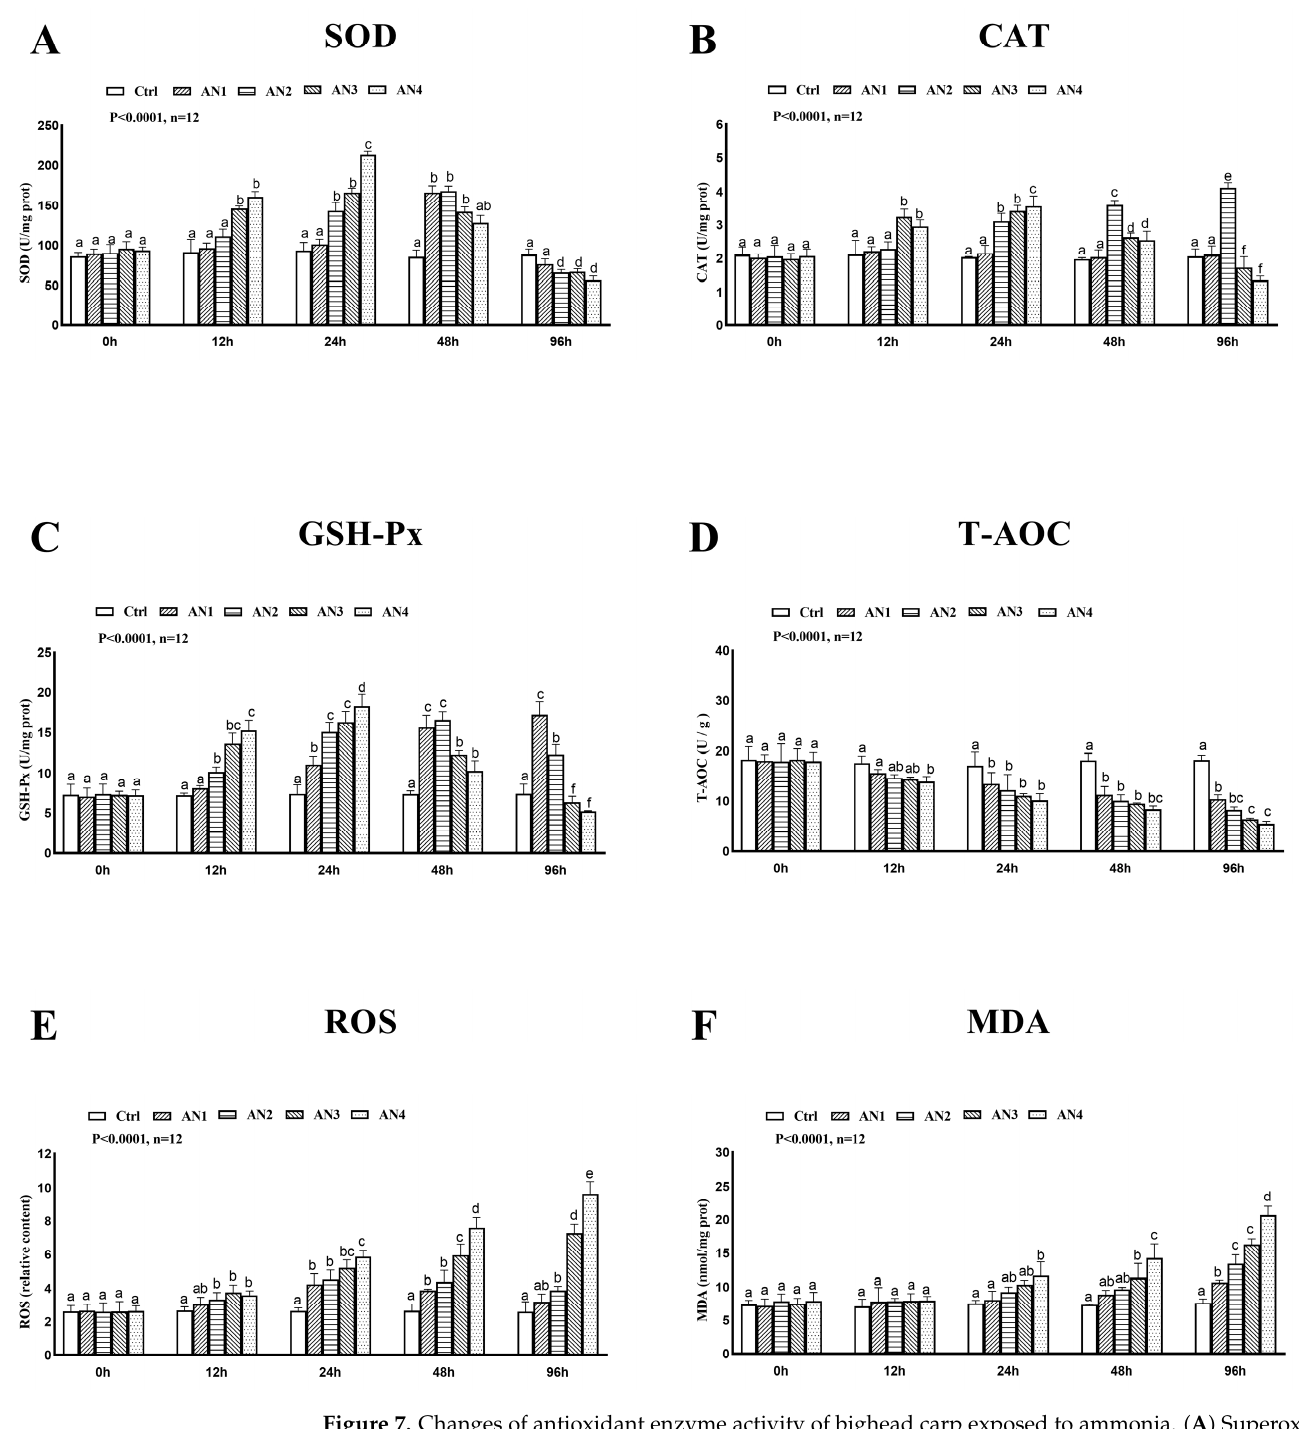
Figure 7. Changes of antioxidant enzyme activity of bighead carp exposed to ammonia. ( A ) Superoxide dismutase (SOD), ( B ) catalase (CAT), ( C ) glutathione peroxidase (GSH-Px), ( D ) total antioxidant capacity (T-AOC.), ( E ) reactive oxygen species (ROS), and ( F ) malondialdehyde (MDA). Values are expressed as mean ± standard error (SE) from triplicate groups ( n = 12). Bars with different letters (a, b, c, d, e, f) differ significantly from those of other groups ( p < 0.05).